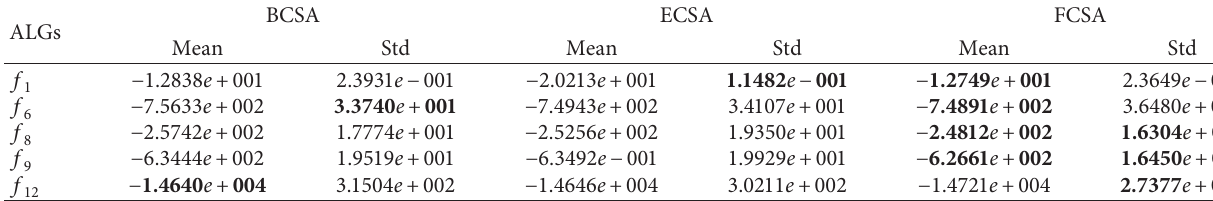
Table 5: Results of BCSA, ECSA, and FCSA when D � 50.